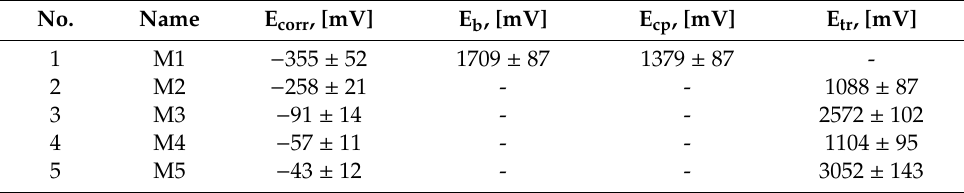
Figure 8. Example polarization curves. Table 8. Results of pitting corrosion test—mean values and standard deviations.